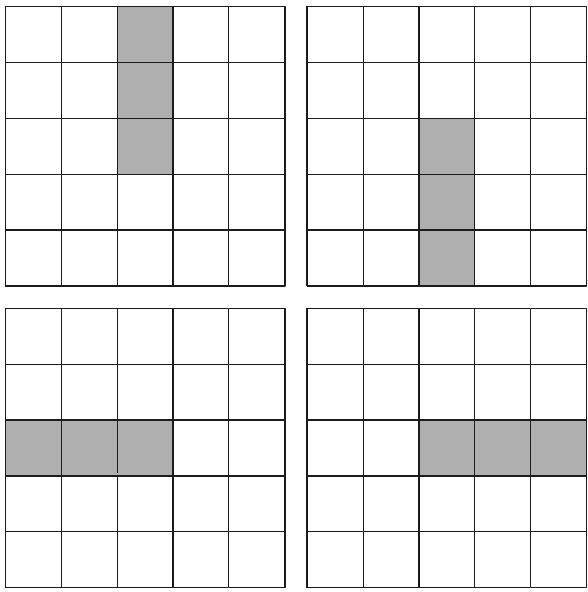
Figure 2: Four directional spreading operators, where the shaded position indicates nonzero element.